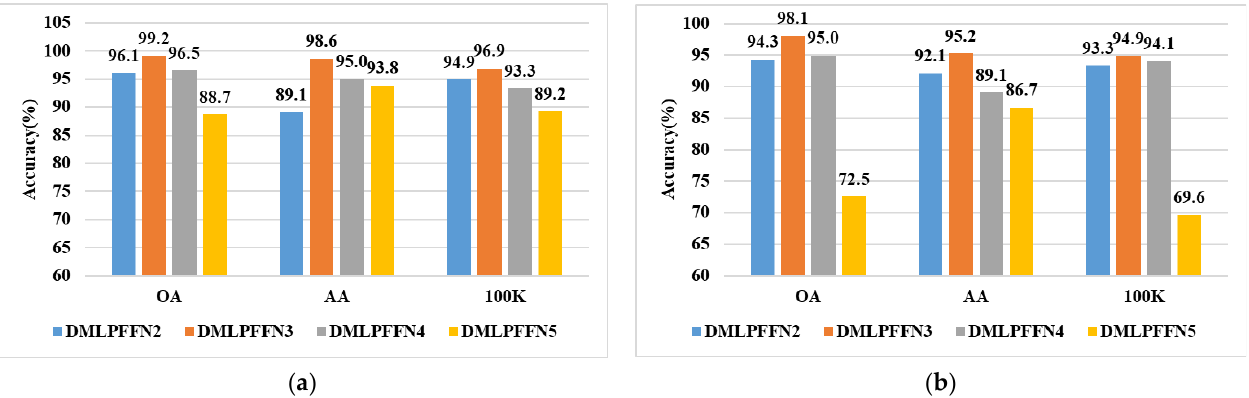
Figure 14. Comparison of the different branch combinations in feature fusion strategy. ( a ) LongKou; ( b ) HanChuan.